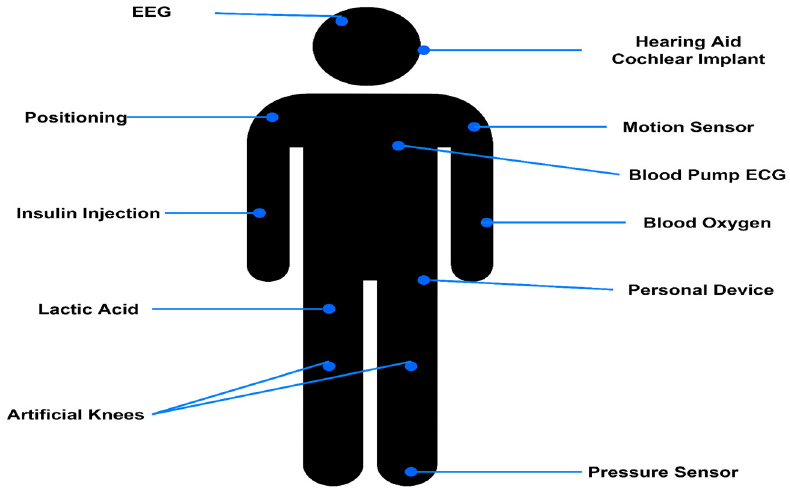
Figure 2. IoT Device.